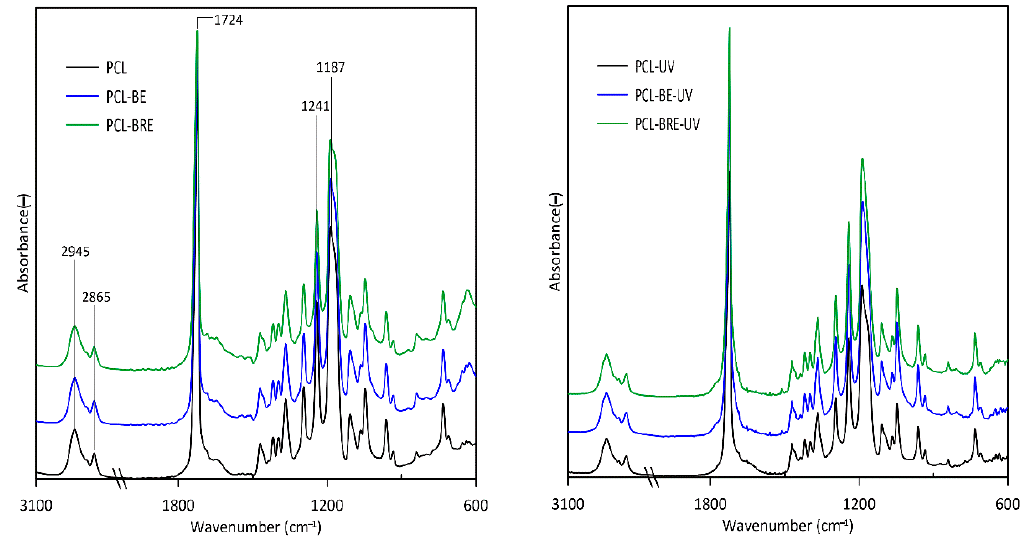
Figure 12. FTIR spectra for the PCL and PCL composite films prior to and following exposure in a UV chamber.